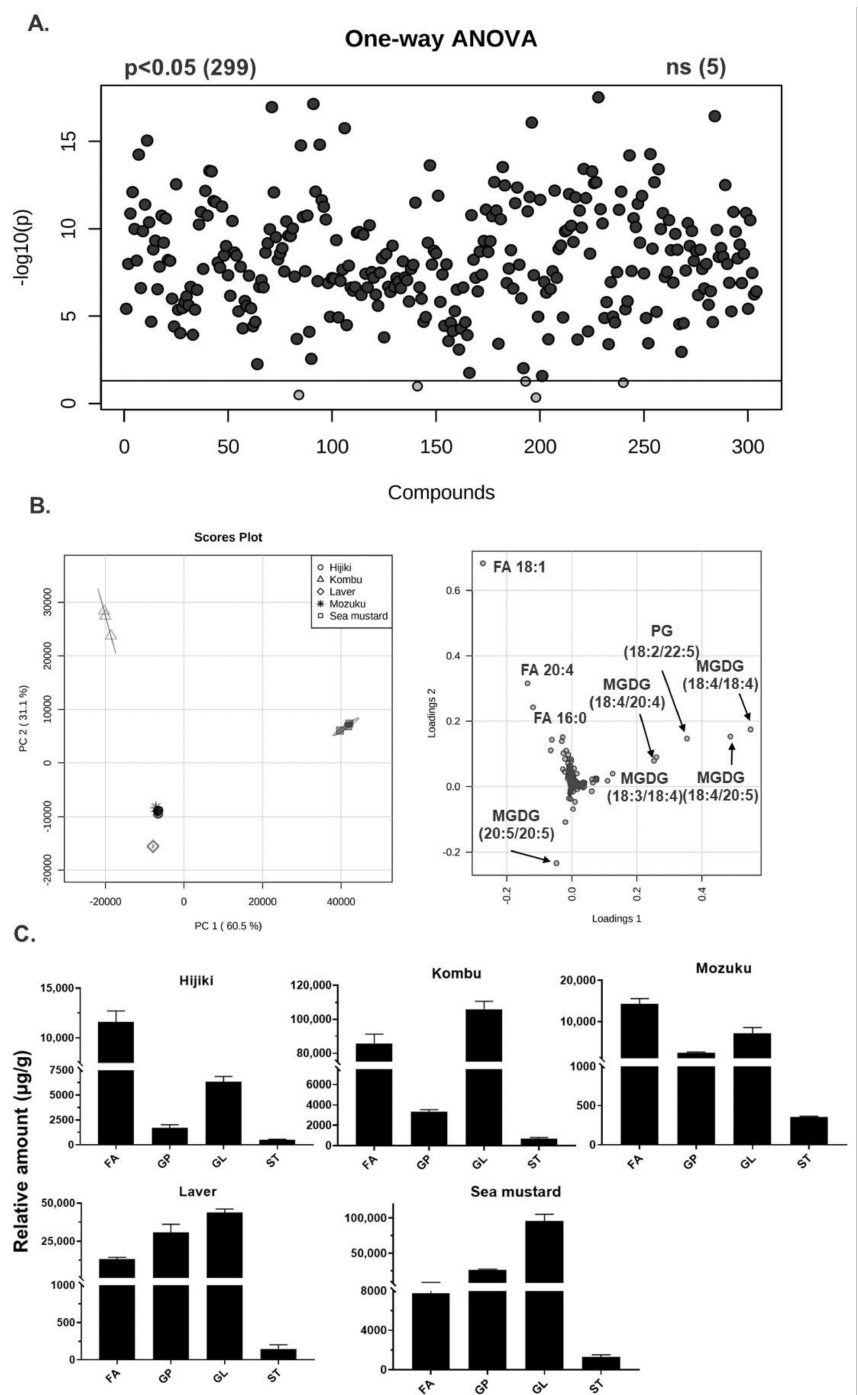
Figure 2. Multivariate analysis and distribution of lipid classes characterized in five species of seaweed. ( A ) One-way ANOVA analysis of all the lipid molecular species (Tukey’s HSD). ( B ) Principal component analysis score plots and loading scores of the lipids characterized in the study. ( C ). Comparison of the relative amount of major lipid classes determined in seaweeds. (Fatty acyls (FAs), Glycerophospholipids (GPs), Glycerolipids (GLs), and Sterols (STs)). ns: non-siginificant